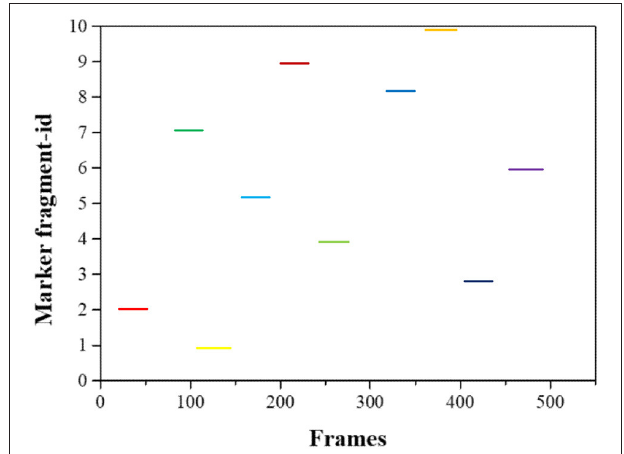
FIGURE 5 | Marked segment before